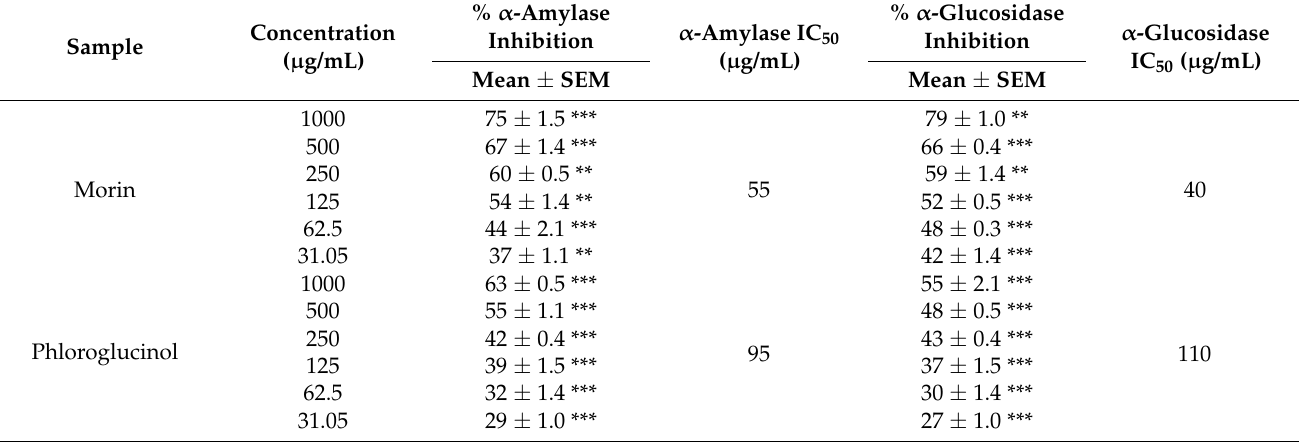
Table 3. Percent α -glucosidase and α -amylase inhibition potential of compounds (morin, phloroglucinol, 1-hexyl benzene) isolated from of Elaeagnus umbellata berries at various